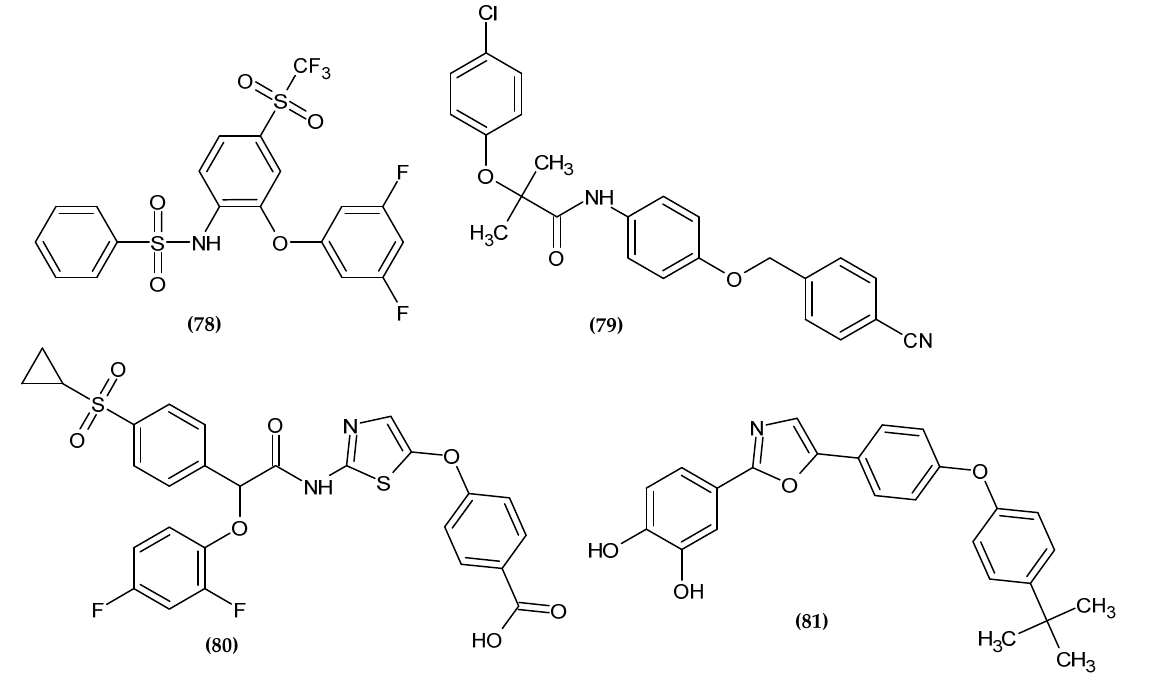
Figure 25. The novel potential agents with anti-diabetic activity bearing a phenoxy group.